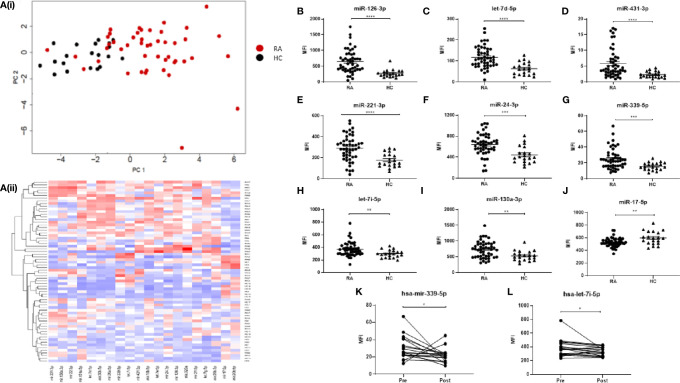

(A) Hierarchical clustering analysis of miRNA expression for the top 20 differentially expressed miRNAs between RA and HC. (i) PCA plots and (ii) Heatmap depicting serum miRNA expression in 49 RA patients and 20 HC individuals. Analysis was performed in R (v4.0) using package Seurat (v3.2.3), function scale and package gplots (v3.1.1), function heatmap2. Distance matrix was generated by Euclidian distance measure and clustering performed with complete agglomeration. PCA analysis was performed in R (v4.0) function prcomp with scaling. (B–J) Expression of 9 miRNAs of interest between RA patients and HC individuals. miRNA expression was determined by Multiplex Circulating miRNA Assay. Graphs show mean fluorescence intensity (MFI) for RA patients (N = 49). HC individuals (N = 20), and (K, L) for RA patients pre- and 3 months post-MTX treatment (N = 18), represented as mean ± SEM. ****p ≤ 0.0001, ***p≤ 0.001, **p ≤ 0.01, *p ≤ 0.05 as determined by Mann-Whitney U test.